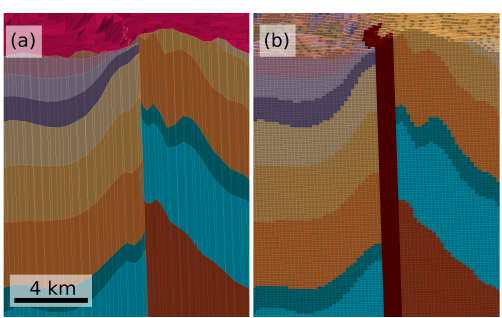
Figure 8. Exemplary comparison of meshes before (a) and after (b) the resampling along a fault; vertical exaggeration 10 given in Fig. 3, and position of viewpoint shown in Fig. 9.